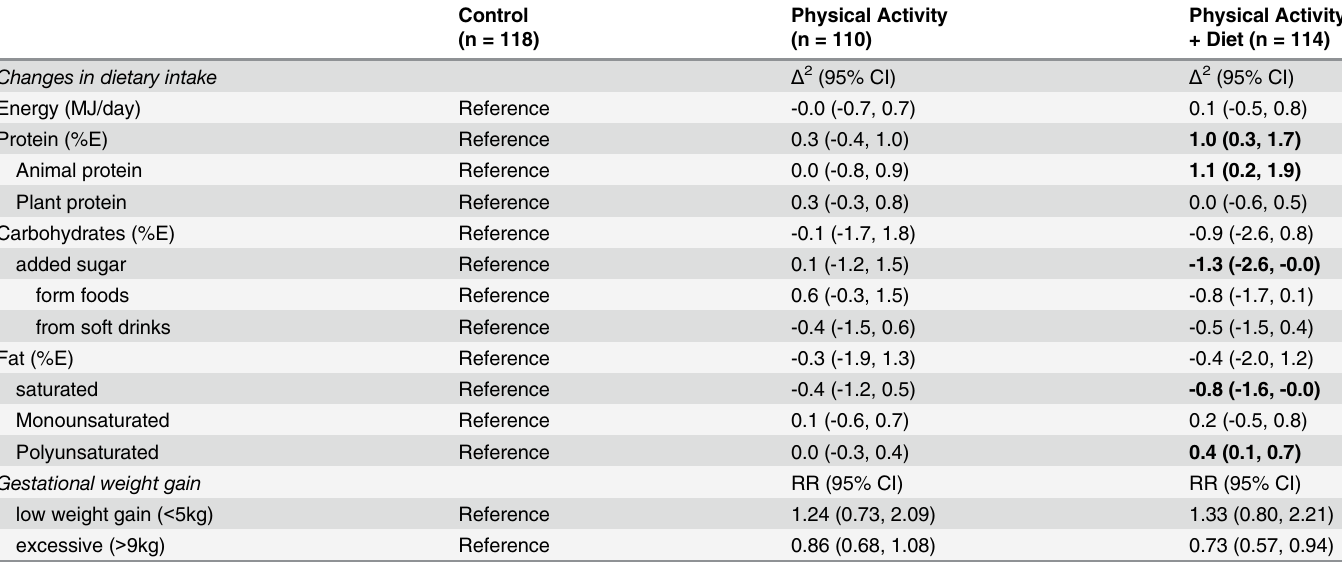
Table 2. Relative changes in dietary intake between baseline and endpoint among subjects reporting their diet at both time points (N = 342). The relative risk of having either low or excessive weight gain as defined by the institute of medicine 1 is also shown for each